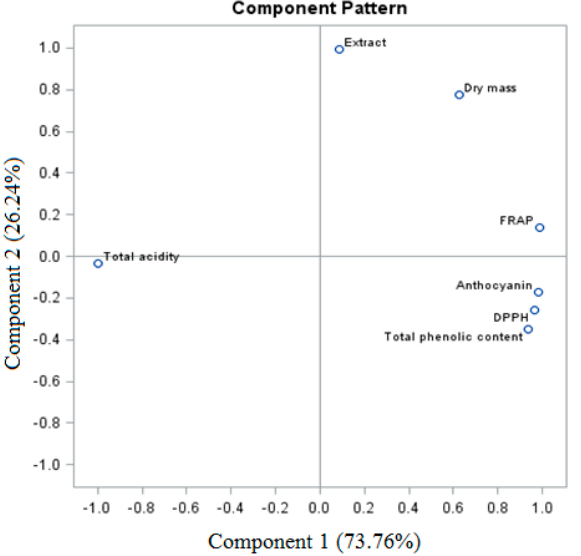
The sum of PC of the total variable for the analyzed grape raisins ‘Einset Seedless’